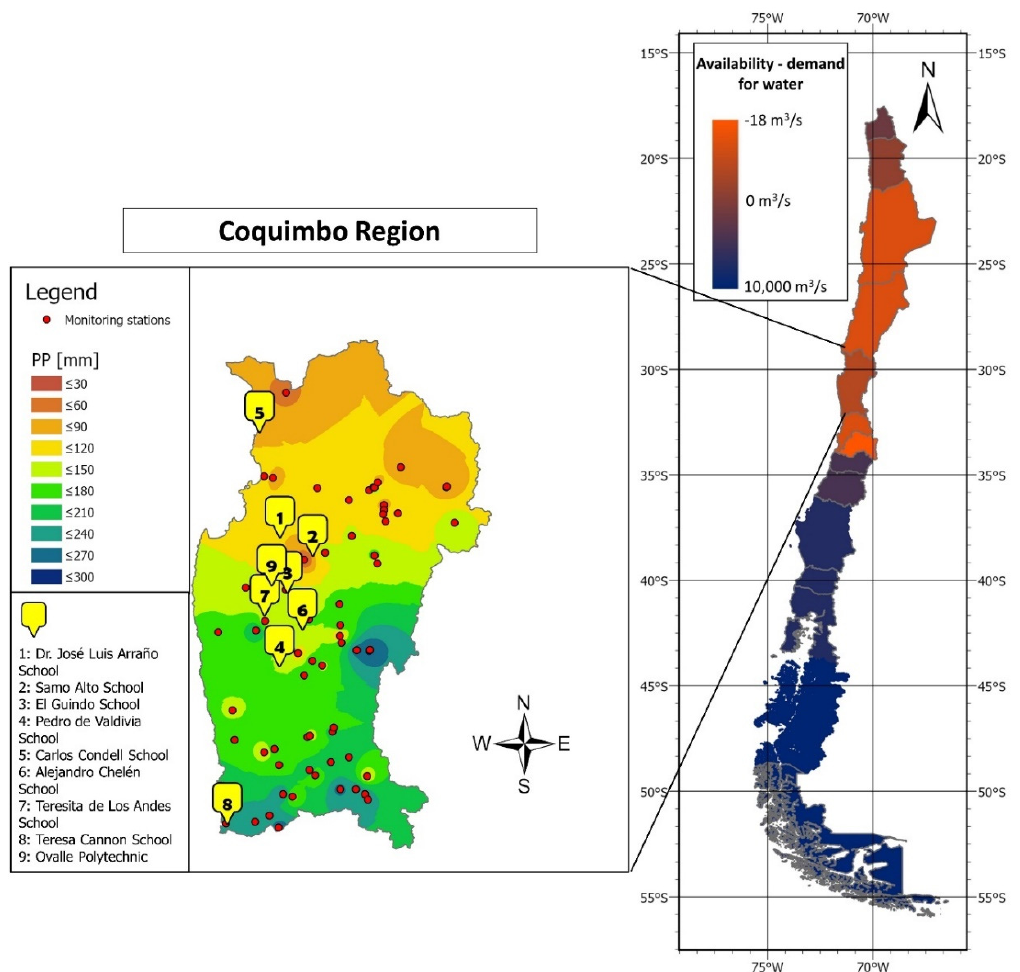
Figure 1. Water availability by administrative regions of Chile and a map of isohyets for the Coquimbo Region with average data from the last 20 years obtained from 69 monitoring stations. The color scale on the map of Chile does not present a linear scale and is intended to visually show if the region has water scarcity. The map also shows the location of the rural public schools in this study. Source: Prepared by the authors based on meteorological data from the Climate Explorer that uses compiled databases of the weather observations available for Chile [22].